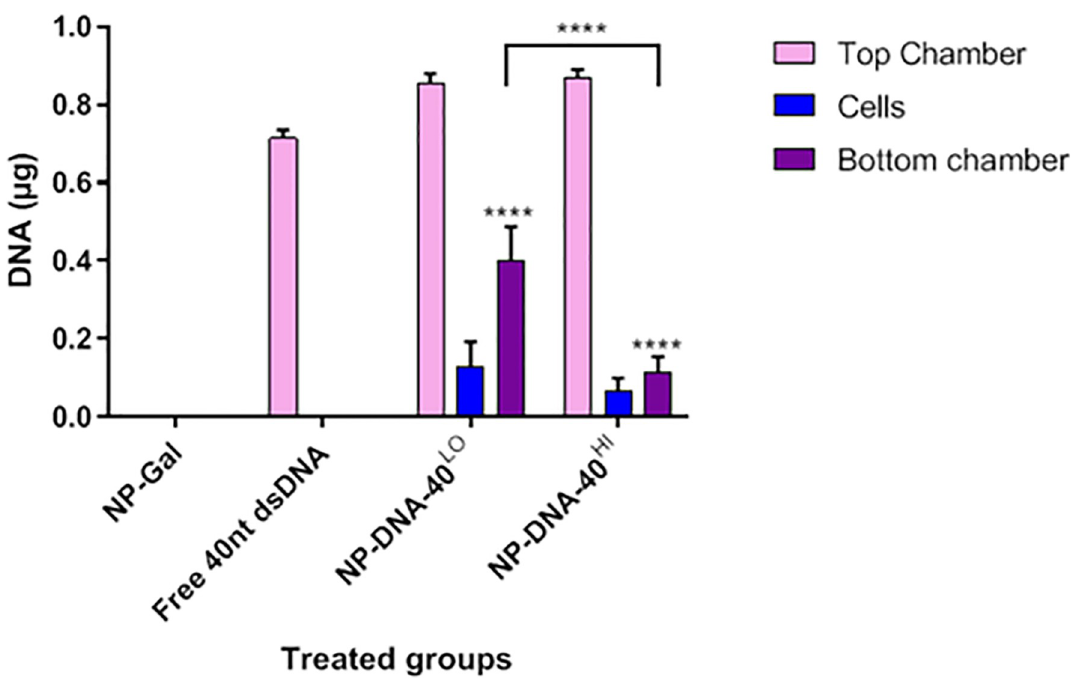
Fig 5. Transport of DNA across brain endothelium by gold nanocarriers. qPCR quantitation of 40nt DNA measured in transwells treated with NP-Gal, free 40nt dsDNA, NP-DNA-40 LO and NP-DNA-40 HI . Tukey’s multiple comparisons test was performed. The level of DNA carried across the endothelium was significantly greater with either of the NP-DNA formulations than for free DNA ( ���� P < 0.0001) and transport by NP-DNA-40 Lo was higher than NP-DNA-40 Hi .